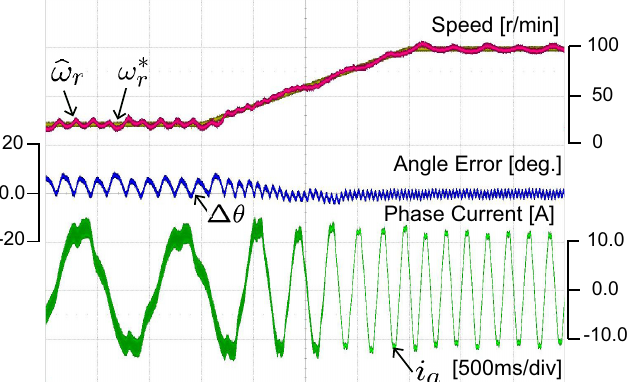
Figure 9. Speed transition from 20 r/min to 100 r/min under 1.0 pu load torque.